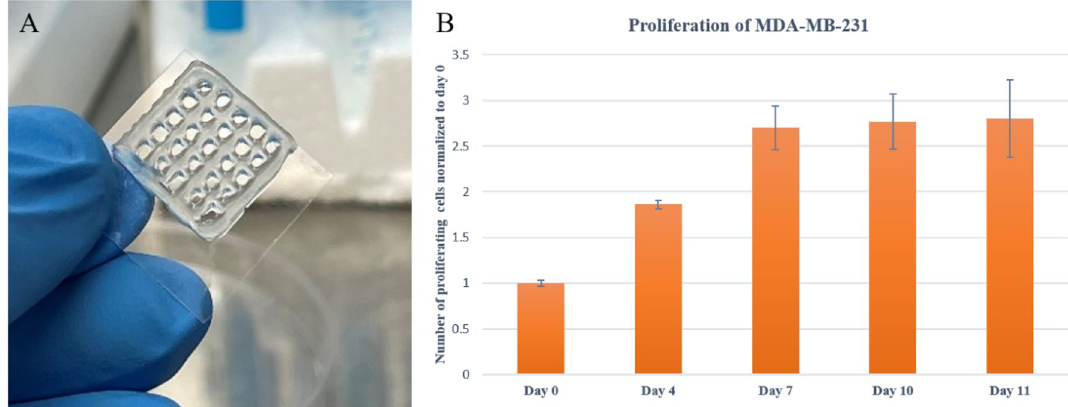
Figure 2. ( A ): Fabricated cell/hydrogel structure using 3D bioprinting technique; ( B ): MDA-MB-231 proliferation embedded in hydrogel network post printing from day 0 to day 11. Error bars represent ± SD, n ≥